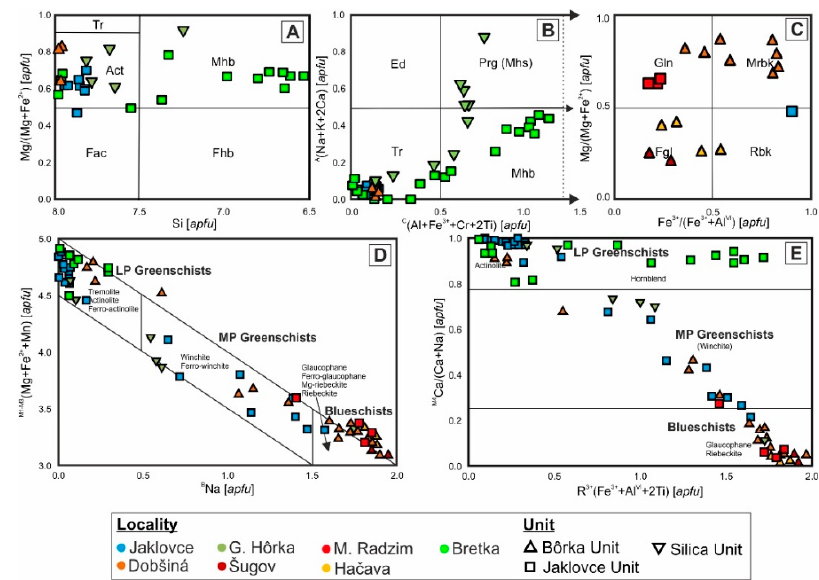
Figure 18. Classification diagrams of amphibole from the Bôrka, Jaklovce and Silica units’ metabasites: ( A , B) classification diagrams of amphiboles after [111,112]; ( C ) classification diagrams of sodium amphiboles after [111]; ( D ) diagram of composition of amphiboles in the Gln/Rbk-Tr/Ac-Ts ternary system; ( E ) amphibole classification according to M4 (Ca/(Ca + Na) vs. R 3+ (Fe 3+ + Al VI + 2Ti).